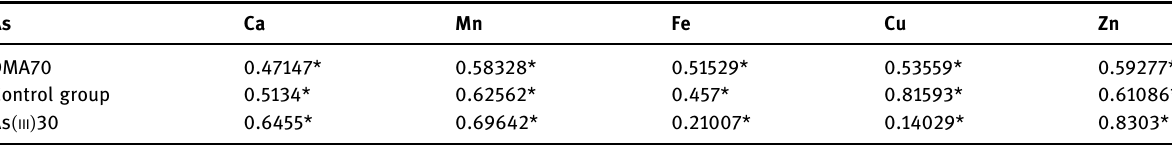
Table 2: Pearson coe ffi cient ( R ) of correlation between As and other elements in honeysuckle stems As Ca Mn Fe Cu